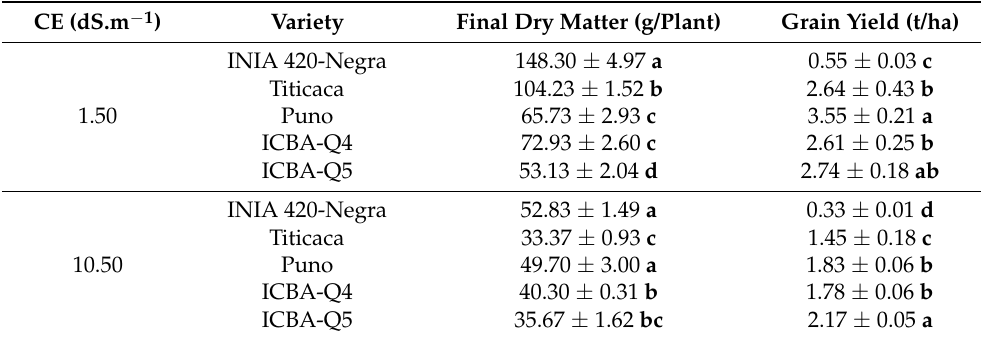
Table 3. Final dry matter and kernel yield according to water irrigation salinity level and quinoa